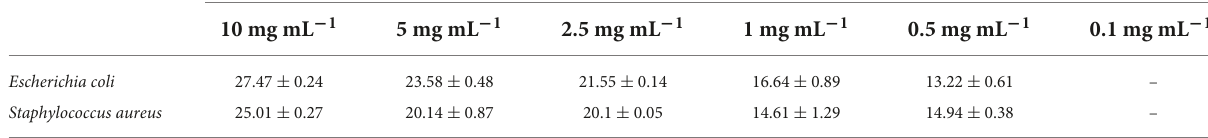
TABLE 3 Antimicrobial activity as indicated by growth-inhibition zone of different concentration of ethyl acetate (EA) crude extract of Penicillium macrosclerotiorum 1151# against gram-negative and gram-positive bacteria. Bacteria